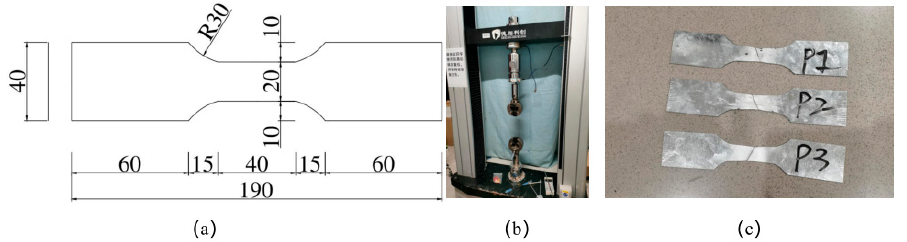
Figure 3. Tensile coupon tests. ( a ) Nominal dimensions of the tensile coupons (mm); ( b ) Universal testing machine; ( c ) Fractured tensile coupons.